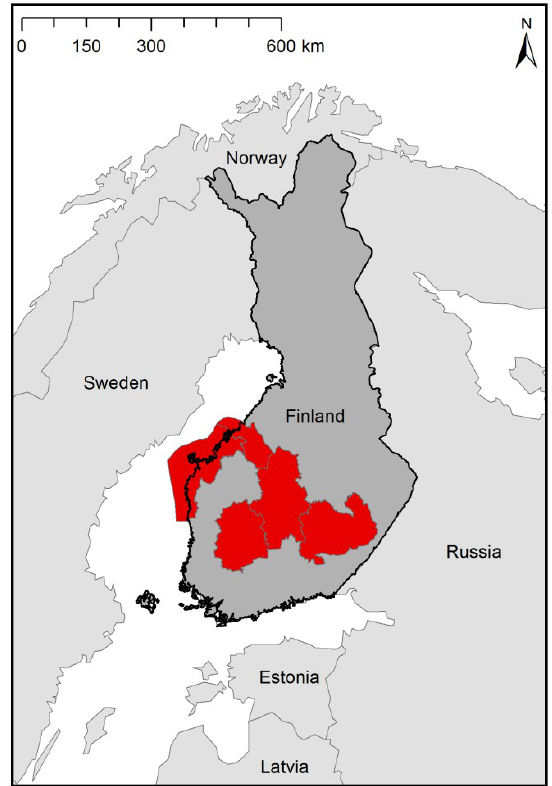
Figure 3: “Bull by the Horns” project region covered five provinces in Finland (colored in red). Administrative boundaries by EuroGeographics and National Land Survey of